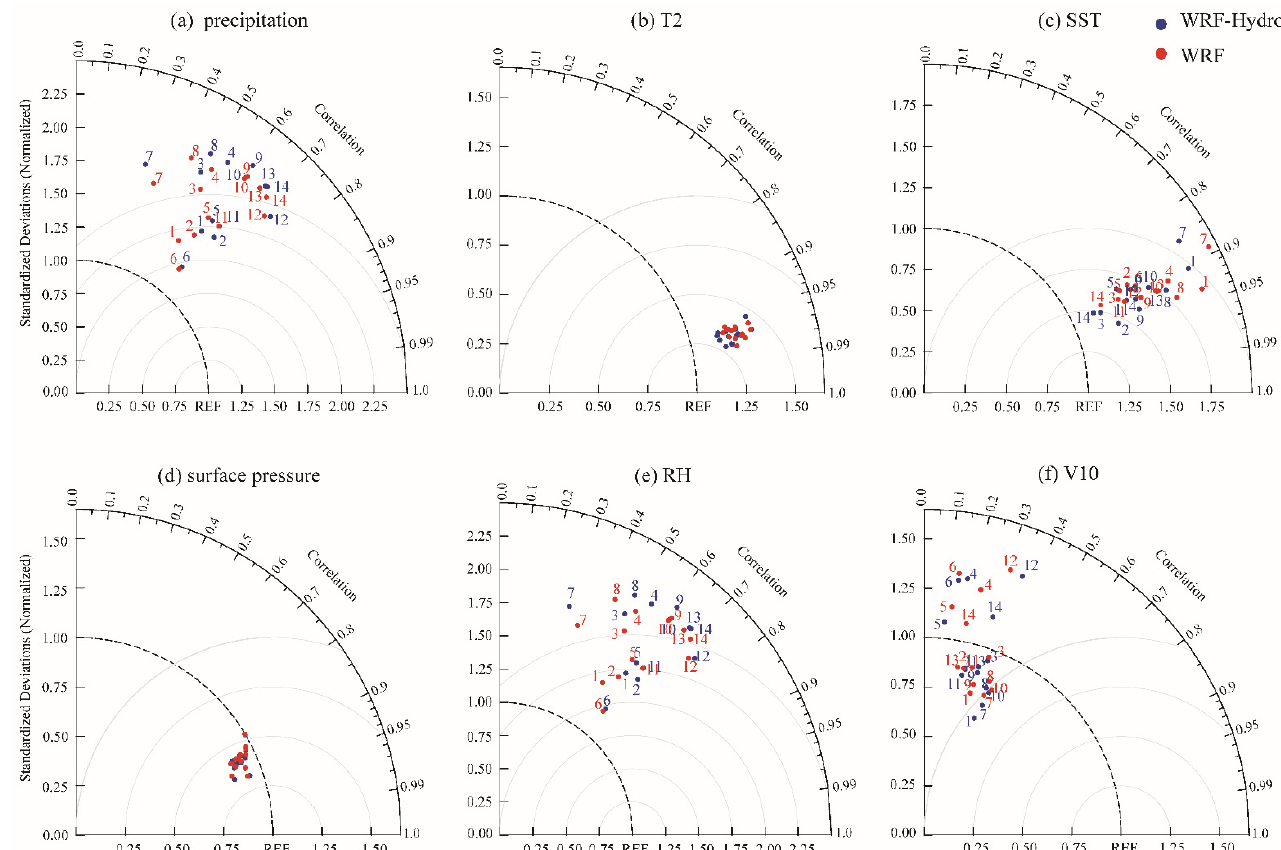
Figure 4. Taylor diagram for simulations compared with 14 CMA observational daily data for; ( a ) precipitation; ( b ) air temperature at 2 m (T2); ( c ) surface skin temperature (SST); ( d ) surface pressure; ( e ) relative humidity at 2 m (RH); ( f ) wind speed at 10 m (V10). The number near the dot in the figure is the ID of the stations listed in Table 2.